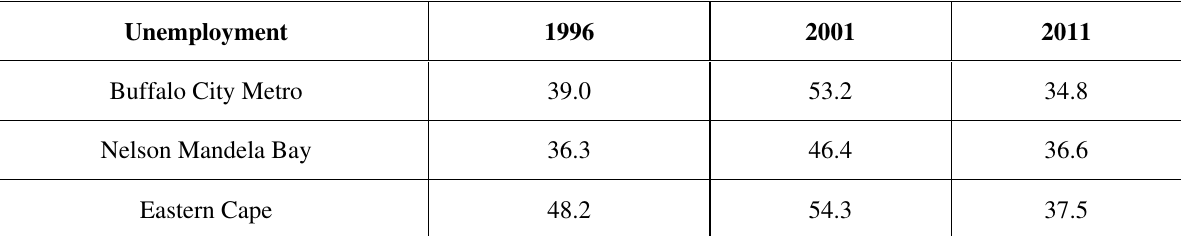
Table 2. Economic indicator in terms of basic